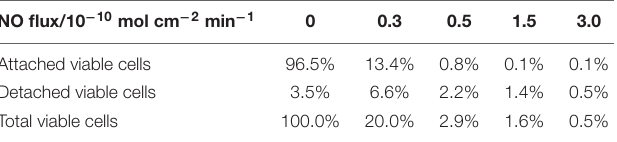
FIGURE 4 | Efficacy of 3 h treatment of BD-2 and various antibiotics against 7-day P. aeruginosa biofilm in the absence and presence of NO release. The concentration of BD-2 is 20 µ g/mL, and concentration for all other antibiotics is 100 µ g/mL. NO release is 1.5 flux. Asterisk denotes statistical significance compared with the control samples ( n = 3 catheters for treatment, n.s., no significance, ∗ p < 0.05; ∗∗ p < 0.01, ∗∗∗ p <